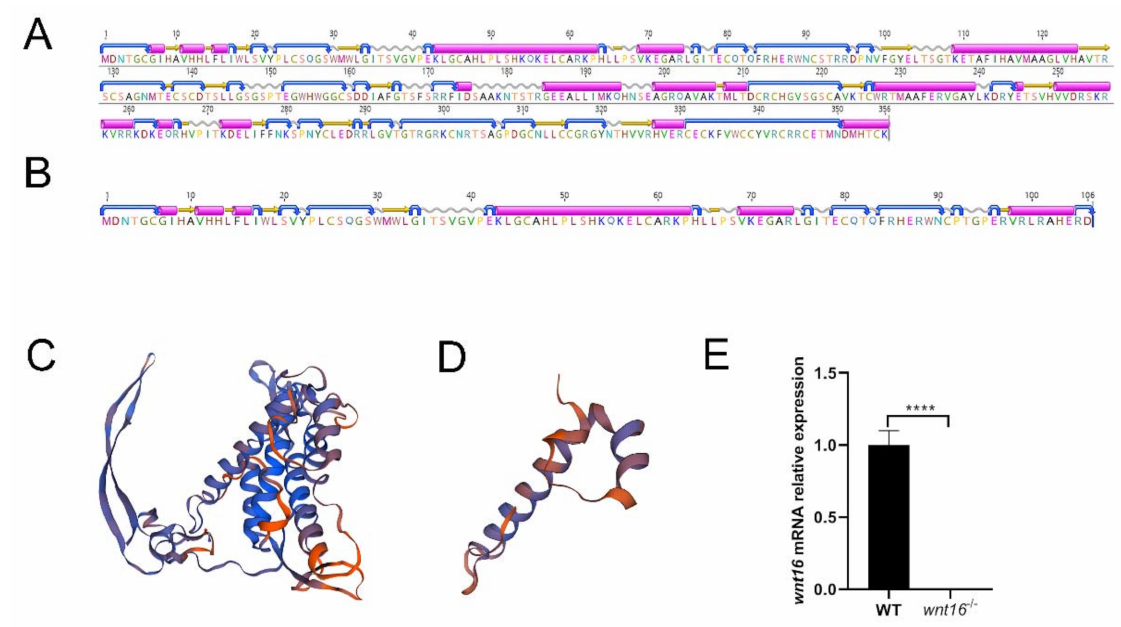
Figure 2. Structure prediction of wnt16 protein and qRT-PCR verification. ( A , B ) Secondary structure prediction in WT and wnt16 − / − zebrafish (purple cylinder indicates alpha helix, yellow arrow indicates beta strand, silver wavy line indicates coil, and blue turning arrow indicates turn). ( C , D ) Tertiary structure prediction in WT and wnt16 − / − zebrafish. ( E ) qRT-PCR analysis of 2dpf WT and wnt16 − / − larvae, showing a statistically significant decrease of wnt16 expression in wnt16 − / − zebrafish. The results are represented as means ± SEM, **** p <